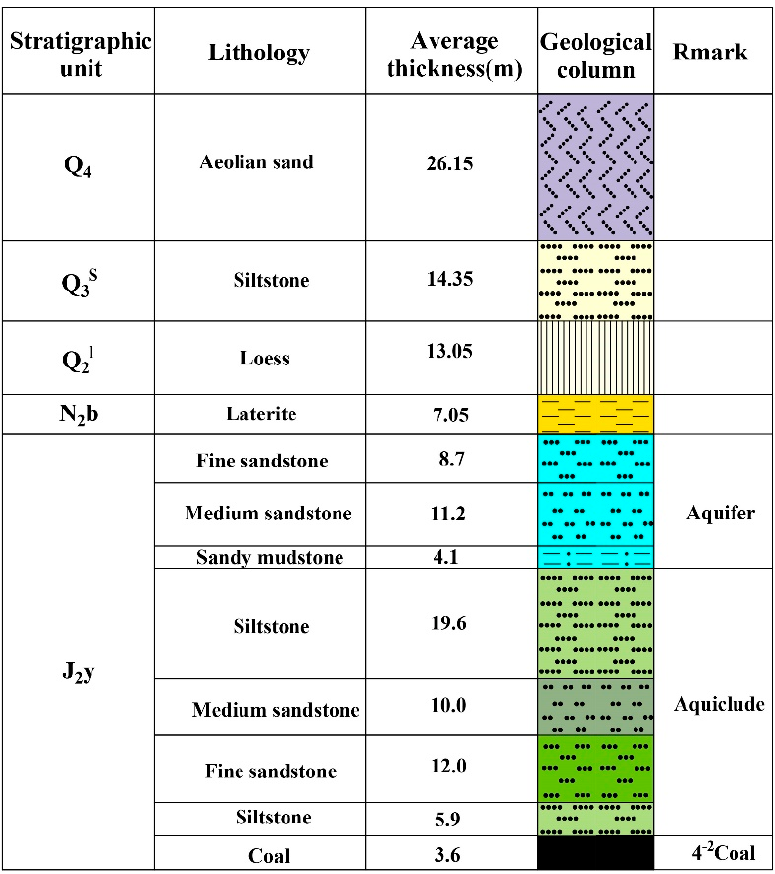
Figure 2. Hydrogeological profile of the study area.